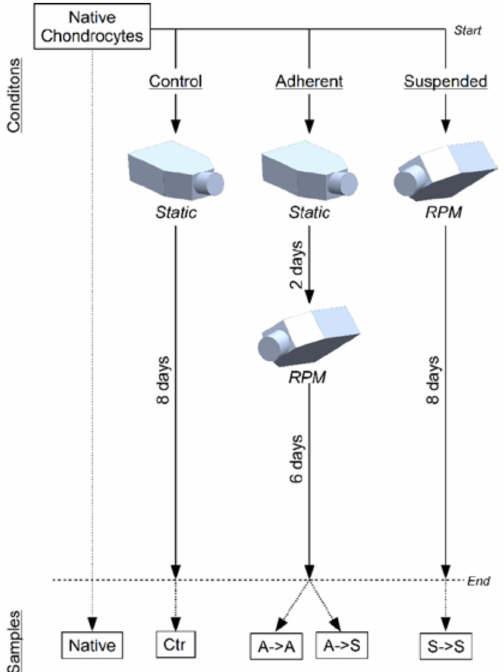
Figure 1. Experiment design. Bovine chondrocytes were distributed to six experimental groups in commercial T25-flasks. The control group was left for eight days in static monolayer culture